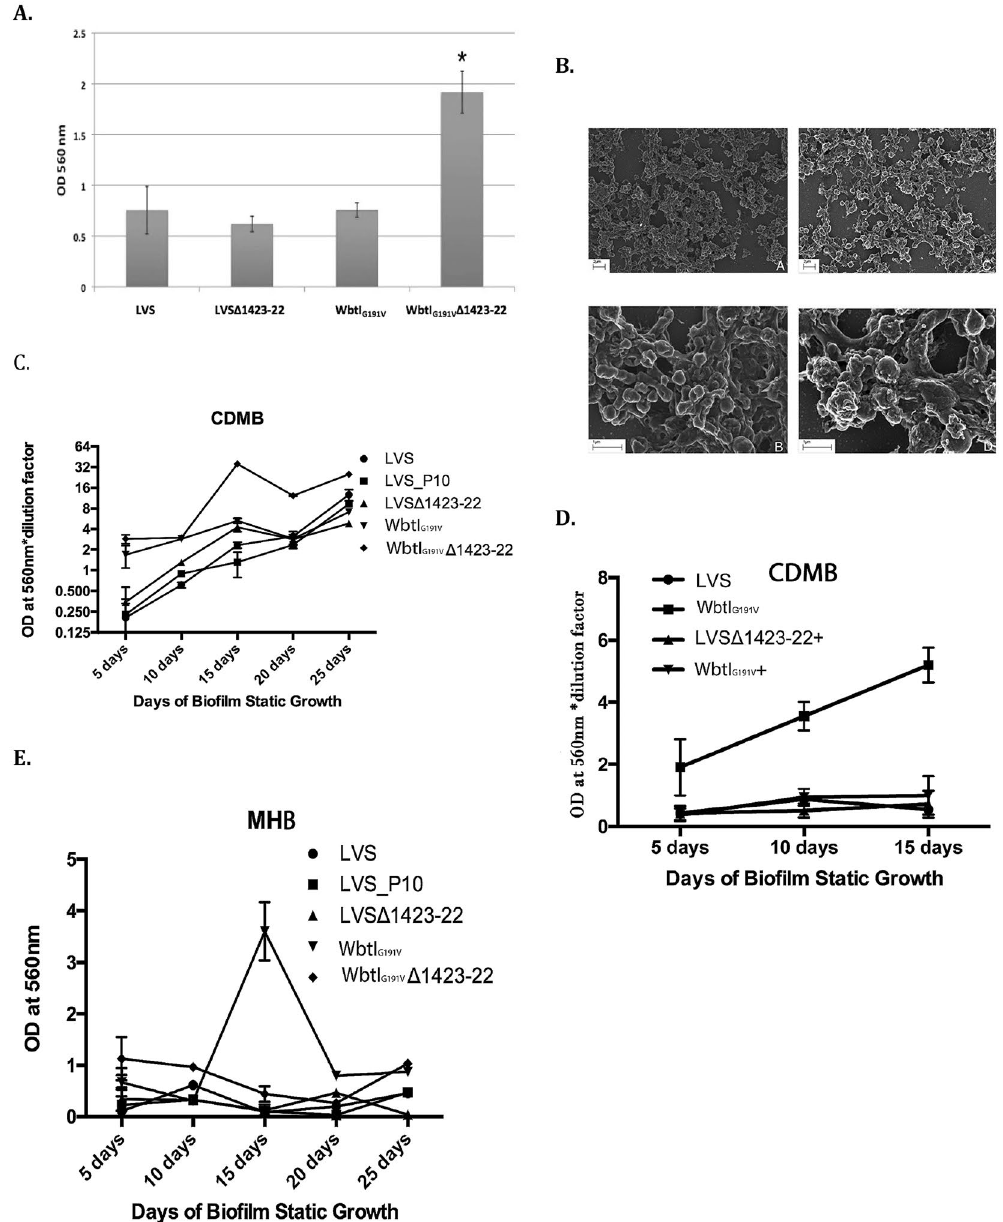
Figure 1. Biofilm development by LVS and surface antigen mutants: attachment and static growth. ( A ) CV attachment assay. Bacteria were grown to stationary phase, inoculated into 96-well plates in triplicate, incubated for 2 hours at 37 °C, washed, and stained with CV to detect cells that have attached. The absorbance was determined at 560 nm after the CV was solubilised with 95% ethanol. * p value < 0.005. ( B ) SEM of F . tularensis biofilms. Biofilms were grown on silicone disks for 5 days and carbon-coated (panels and strains: (A,B), LVS; (C,D), LVS Δ 1423-22). After 5 days growth, no difference was seen in overall attachment or biofilm formation. At increased magnification the surface of LVS Δ 1423-22 appeared more granular than the parent, which could be the result of CLC deficiency. ( C , D , E ) Effect of growth medium on biofilm formation by LVS, glycose-deficient mutants, and complemented strains. C, biofilm formation by parent and mutant strains grown in CDMB; D, biofilm formation by parent and complemented mutant strains (LVS Δ 1423-22 + and WbtI G191V + ) grown in CDMB with O-Ag mutant WbtI G191V included for comparison; E, biofilm formation by parent and mutant strains grown in MHB. A marked increase in biofilm formation by WbtI G191V Δ 1423-22 occurred in MHB medium after 15 days incubation that was not observed following growth in passages to obtain KY99-3387_P10 to enhance CLC expression (attempts to isolate a grey, O-antigen-deficient variant of strain KY99-3387 were unsuccessful). As for LVS, strain KY99-3387_P10 formed significantly less biofilm by 10 and 15 days incubation than non-subcultured strain KY99-3387 (Fig. 3), supporting the evidence that growth conditions that enhance surface carbohydrate expression reduce biofilm formation of type B strains.